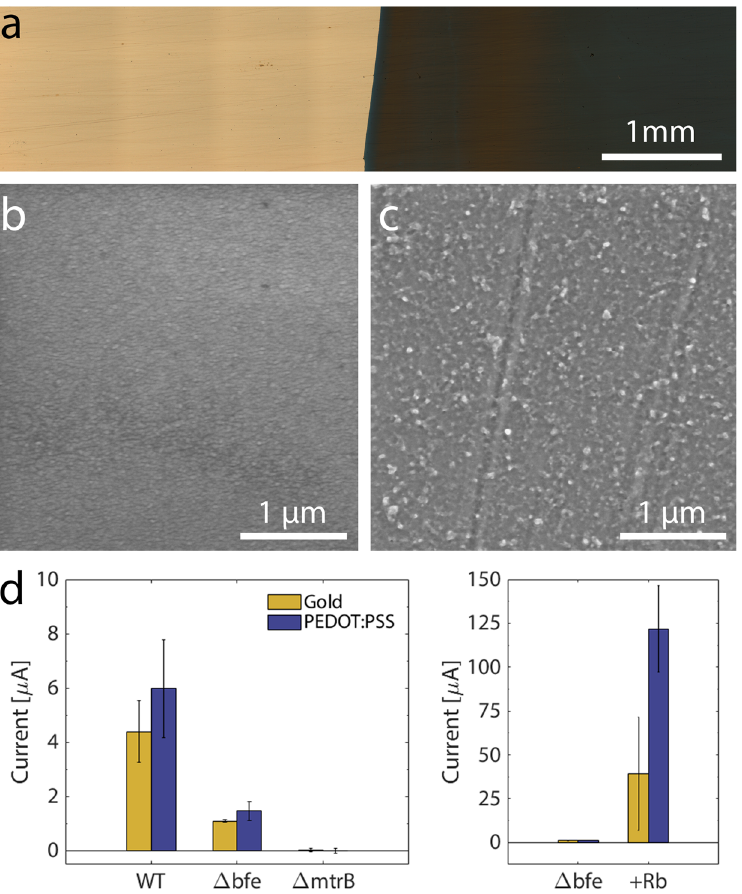
Figure 5. S. oneidensis MR-1 transfers metabolic current through PEDOT:PSS by both direct and flavin- mediated electron transfer. ( a ) 5x magnification of Au/PEDOT:PSS deposited on slide. ( b ) SEM of gold thin film surface. ( c ) SEM of PEDOT:PSS film. ( d , left) Average current after 12 hours for WT, Δ mtrB and Δ bfe strains on gold and PEDOT:PSS films and ( d , right) the Δ bfe current production before and 12 hours after addition of 10 μ M riboflavin